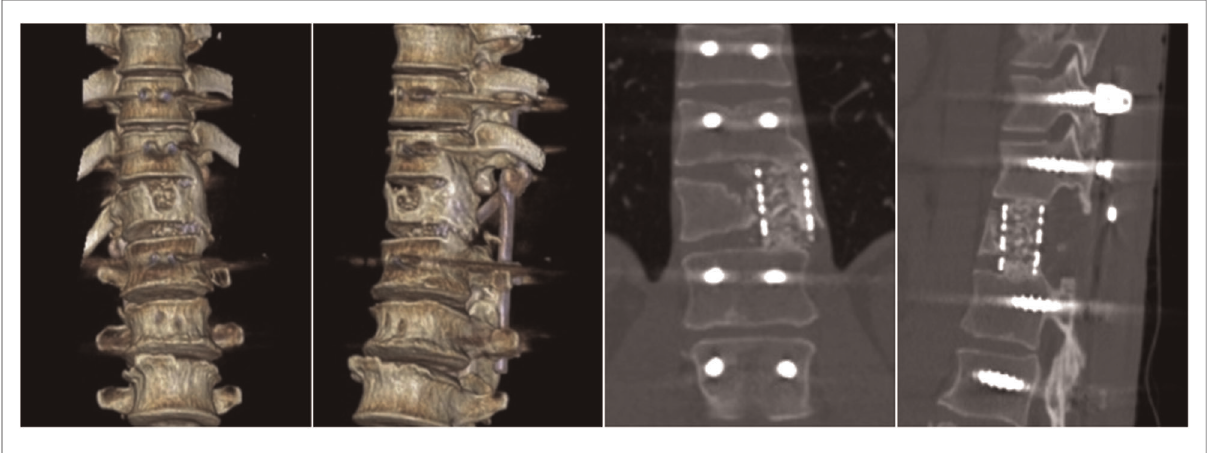
FIGURE 9 Thoracolumbar 3D CT (Eighteen months after